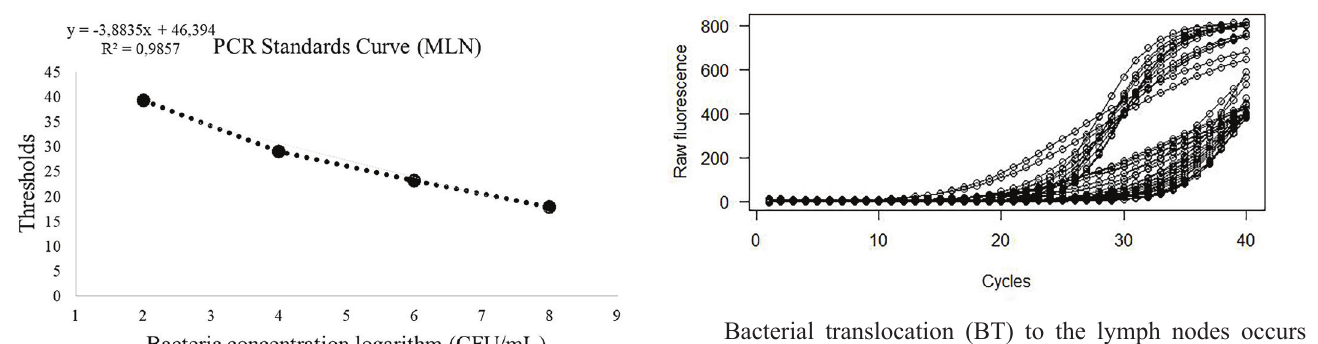
Figure 4 - Polymerase chain reaction (PCR) standards Curve in group E. coli of 102,104, 106, 108 CFU/mL with mesenteric lymph nodes tissue (MLN)